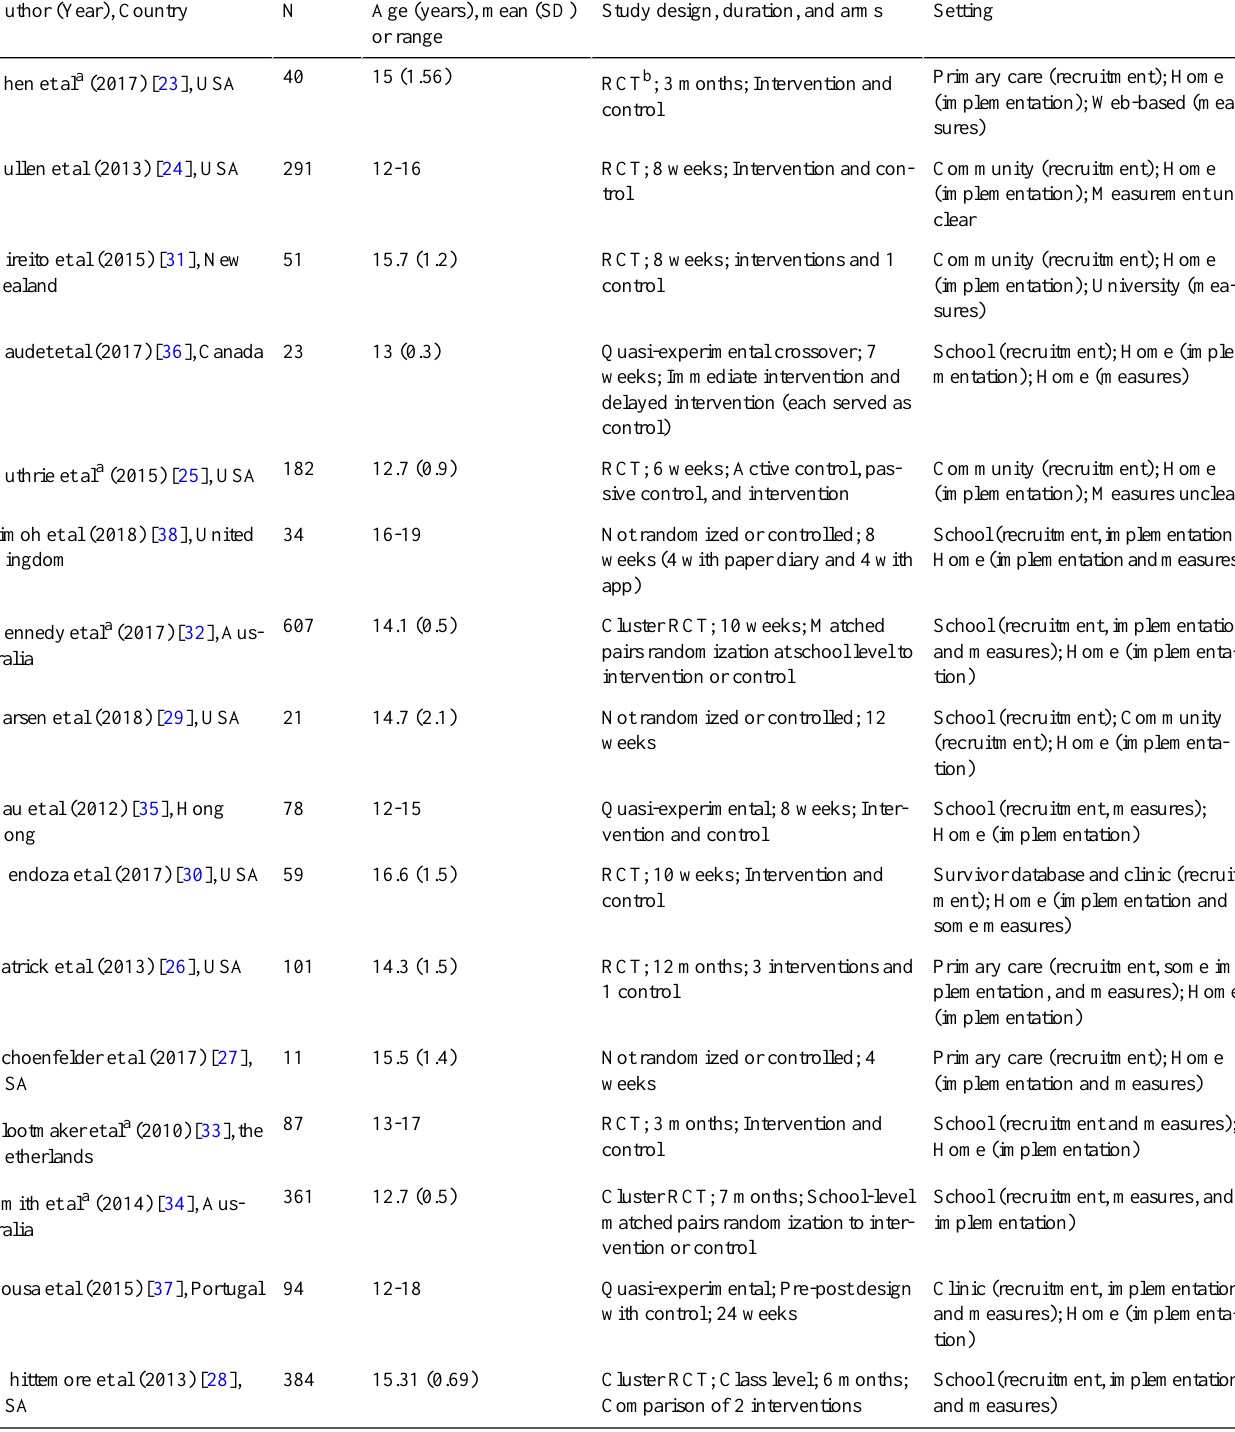
Table 1. Description of included studies. rangeNAuthor (Year), Country